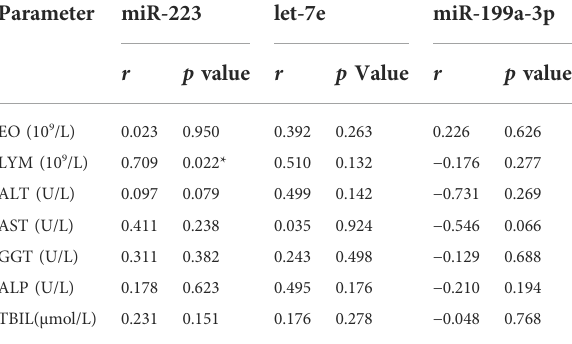
TABLE 4 Correlation Analysis Between differentially expressed EV miRNAs and Clinical Information.